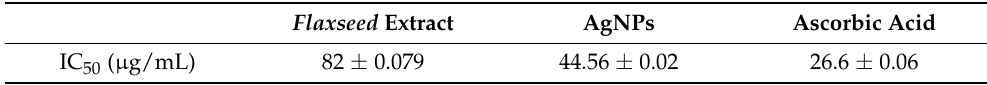
Table 1. IC 50 values of flaxseed extract, AgNPs, and ascorbic